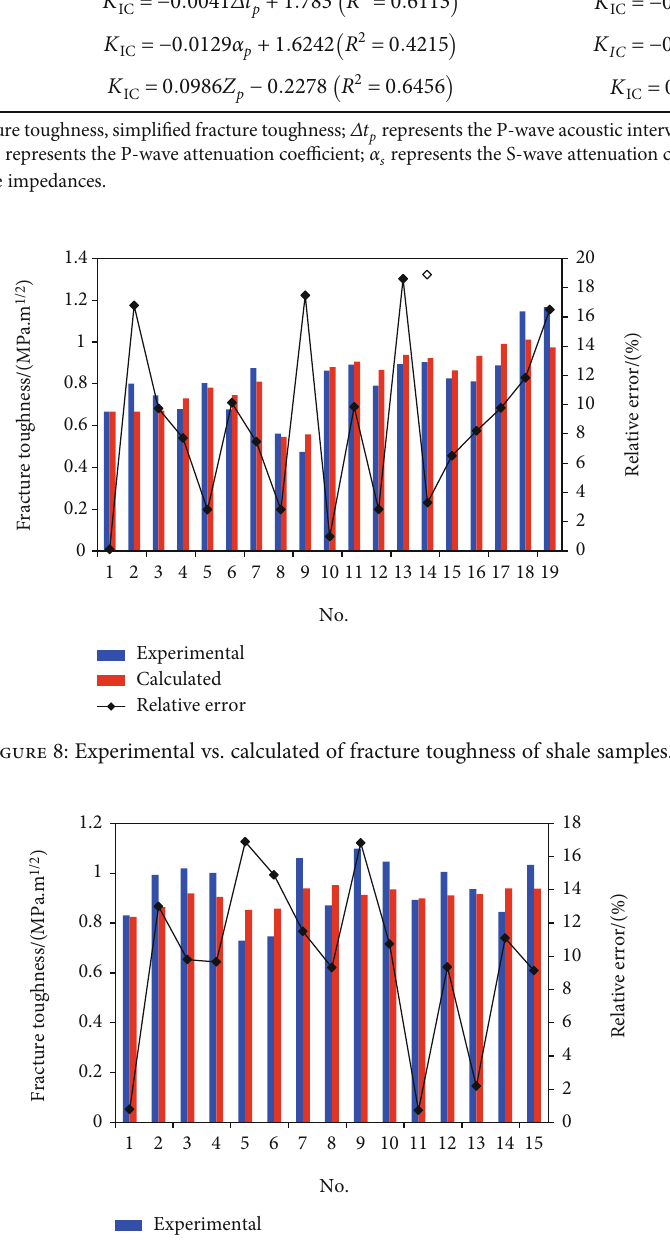
Table 1: The relationships between fracture toughness and acoustic parameters of shale samples.